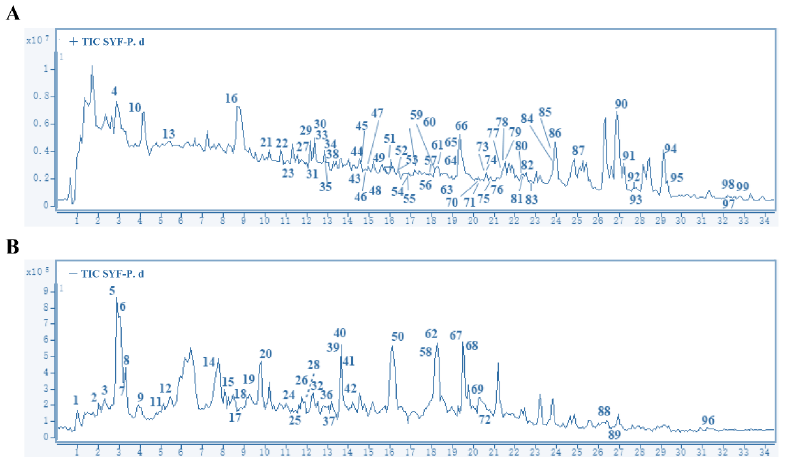
Figure 1. Total ion chromatogram of SYF as determined by HPLC-MS/MS. Positive ion mode ( A ) and negative ion mode ( B ). The X axis represents retention time (min), and the Y axis represents ionic strength.